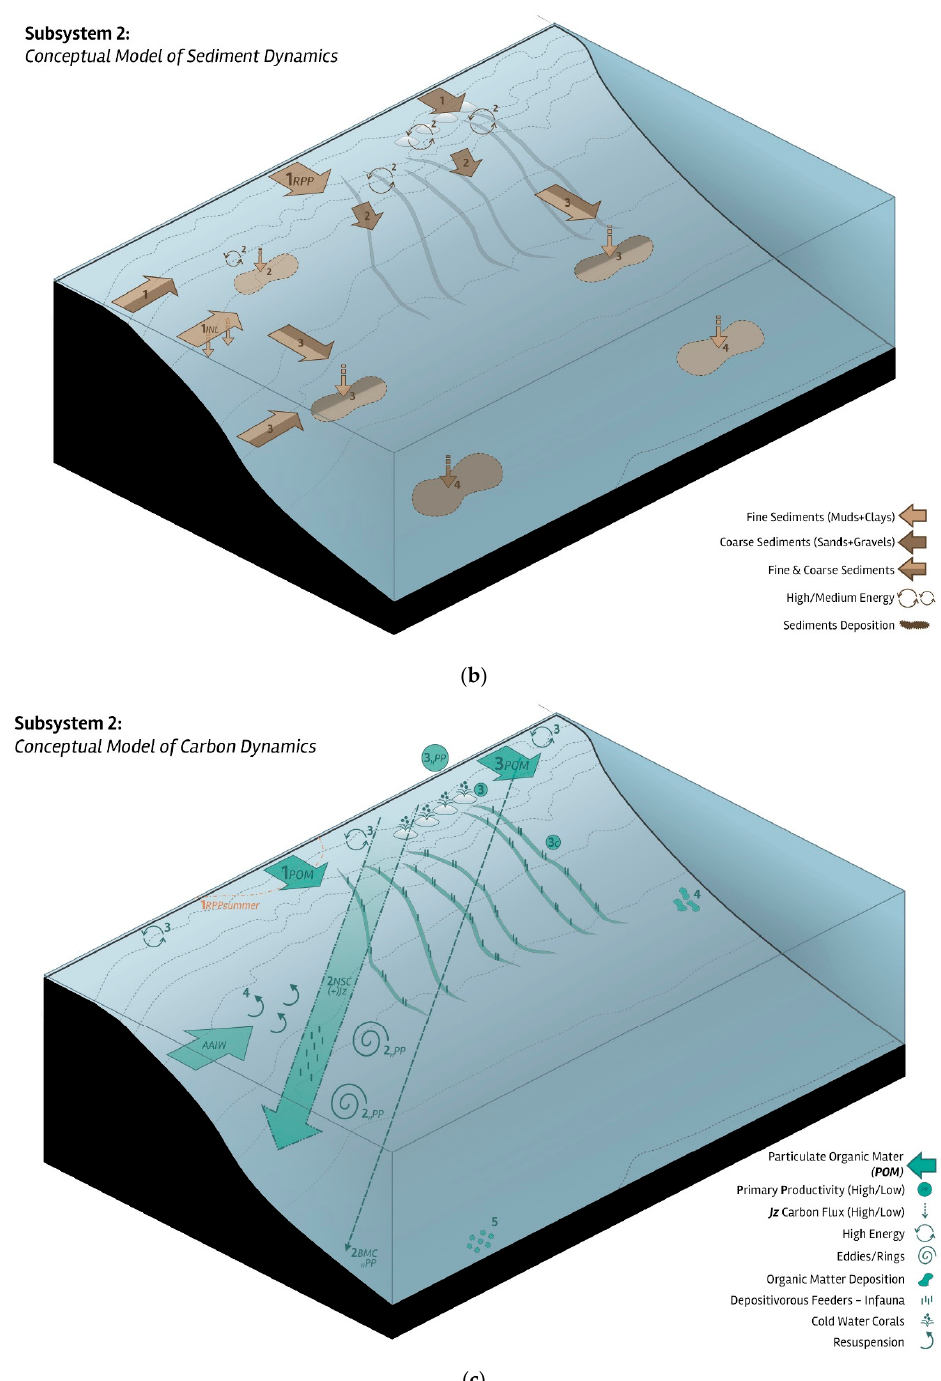
Figure 7. ( a ): Conceptual model of the hydrodynamics process (subsystem 2; slope/continental rise 180–4500 m). R í o de la Plata Plume (RPP), Subantarctic Waters (SAW), Tropical Water (TW), South Atlantic Central Water (SACW), Antarctic Intermediate Water (AAIW), recirculated Antarctic Intermediate Water (AAIWr), Malvinas Current (MC), Brazil Current (BC), Brazil–Malvinas Conflu- ence (BMC), North Atlantic Deep Water (NADW), Antarctic Bottom Water (AABW). ( b ): Conceptual model of sediment dynamics (subsystem 2; slope/continental rise 180–4500 m). R í o de la Plata Plume (RPP), intermediate nepheloids layers (INL). ( c ): Conceptual model of carbon dynamics (subsystem 2; slope/continental rise 180–4500 m). R í o de la Plata Plume (RPP), Antarctic Intermediate Water (AAIW), Brazil–Malvinas Confluence